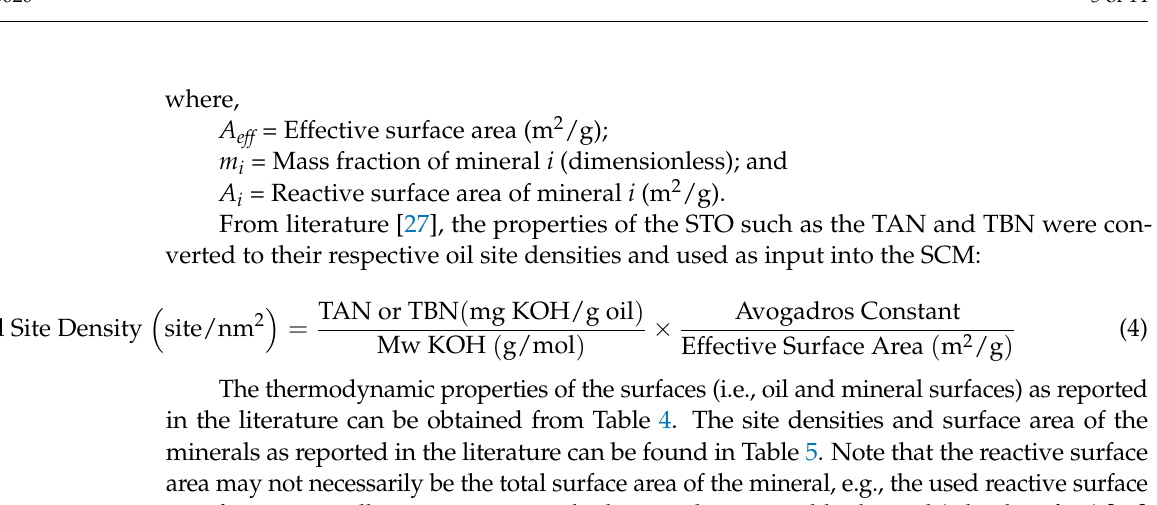
Table 4. SCM input parameters.